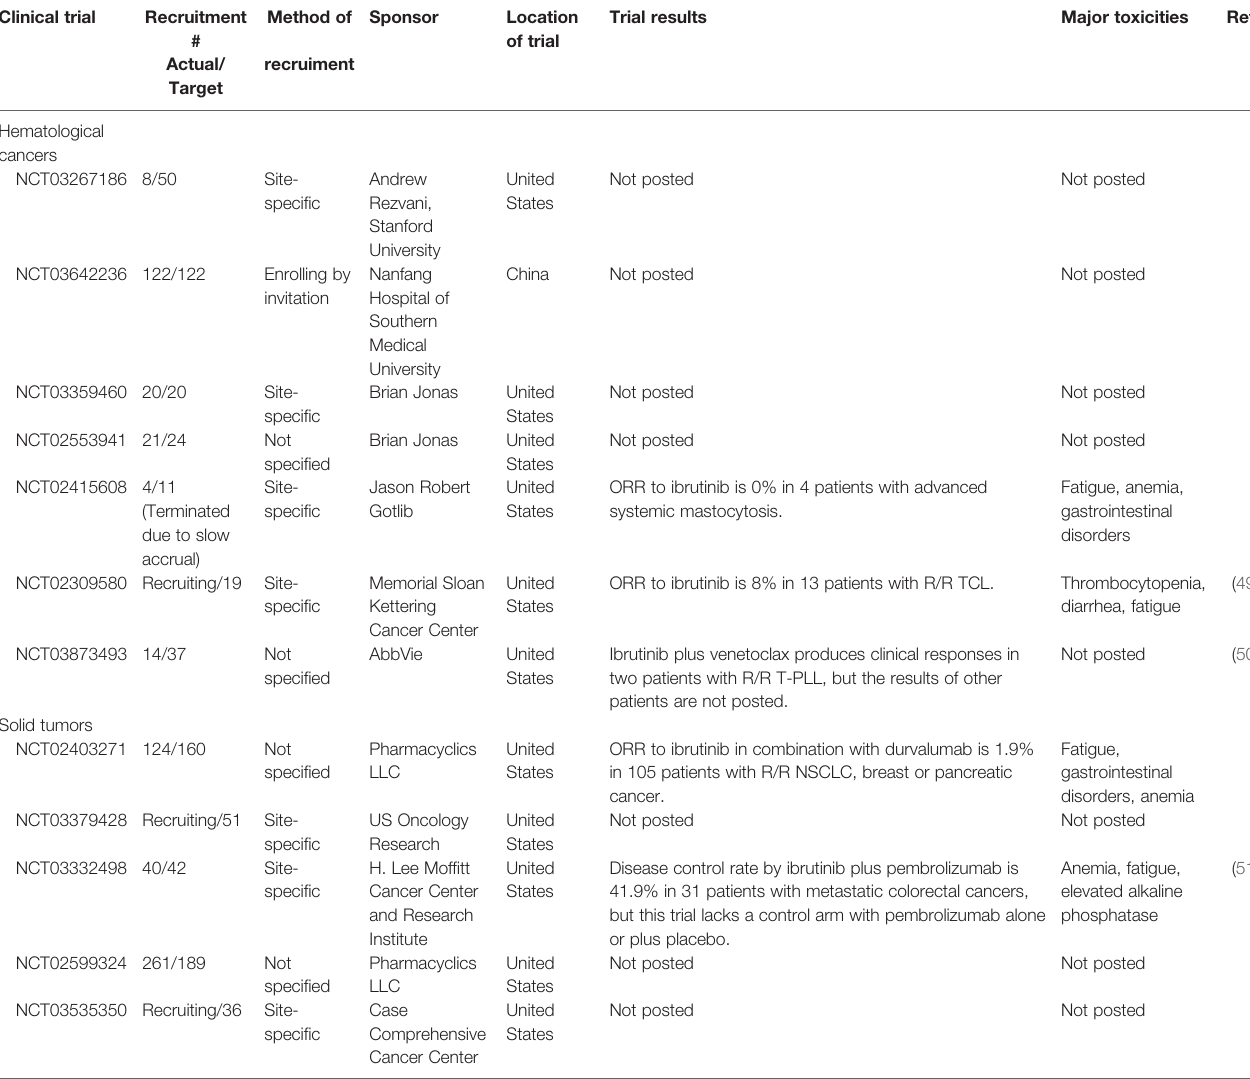
TABLE 2 | Recruiting info and preliminary results of clinical trials with ibruitinib and acalabrutinib in human diseases beyond B cell malignancies. Clinical